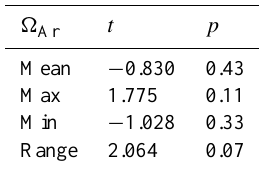
Table 5. Results from Generalized Linear Models (glm package in R) with gaussian distribution testing the effect of saturation of omega aragonite ( (cid:127) Ar , predictor) on the CaCO 3 load (m − 2 ) on the